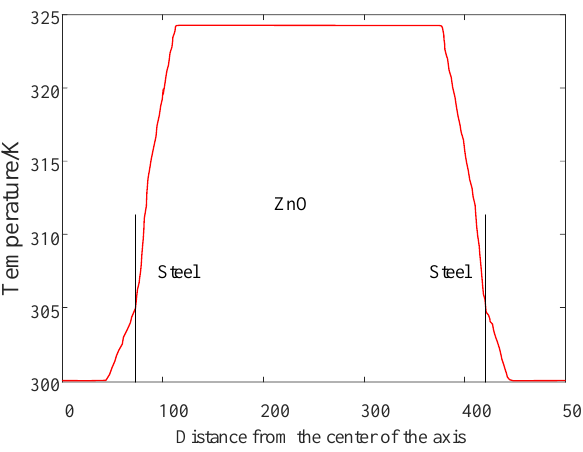
Figure 15. The axial temperature distribution of seventh group valve plate.